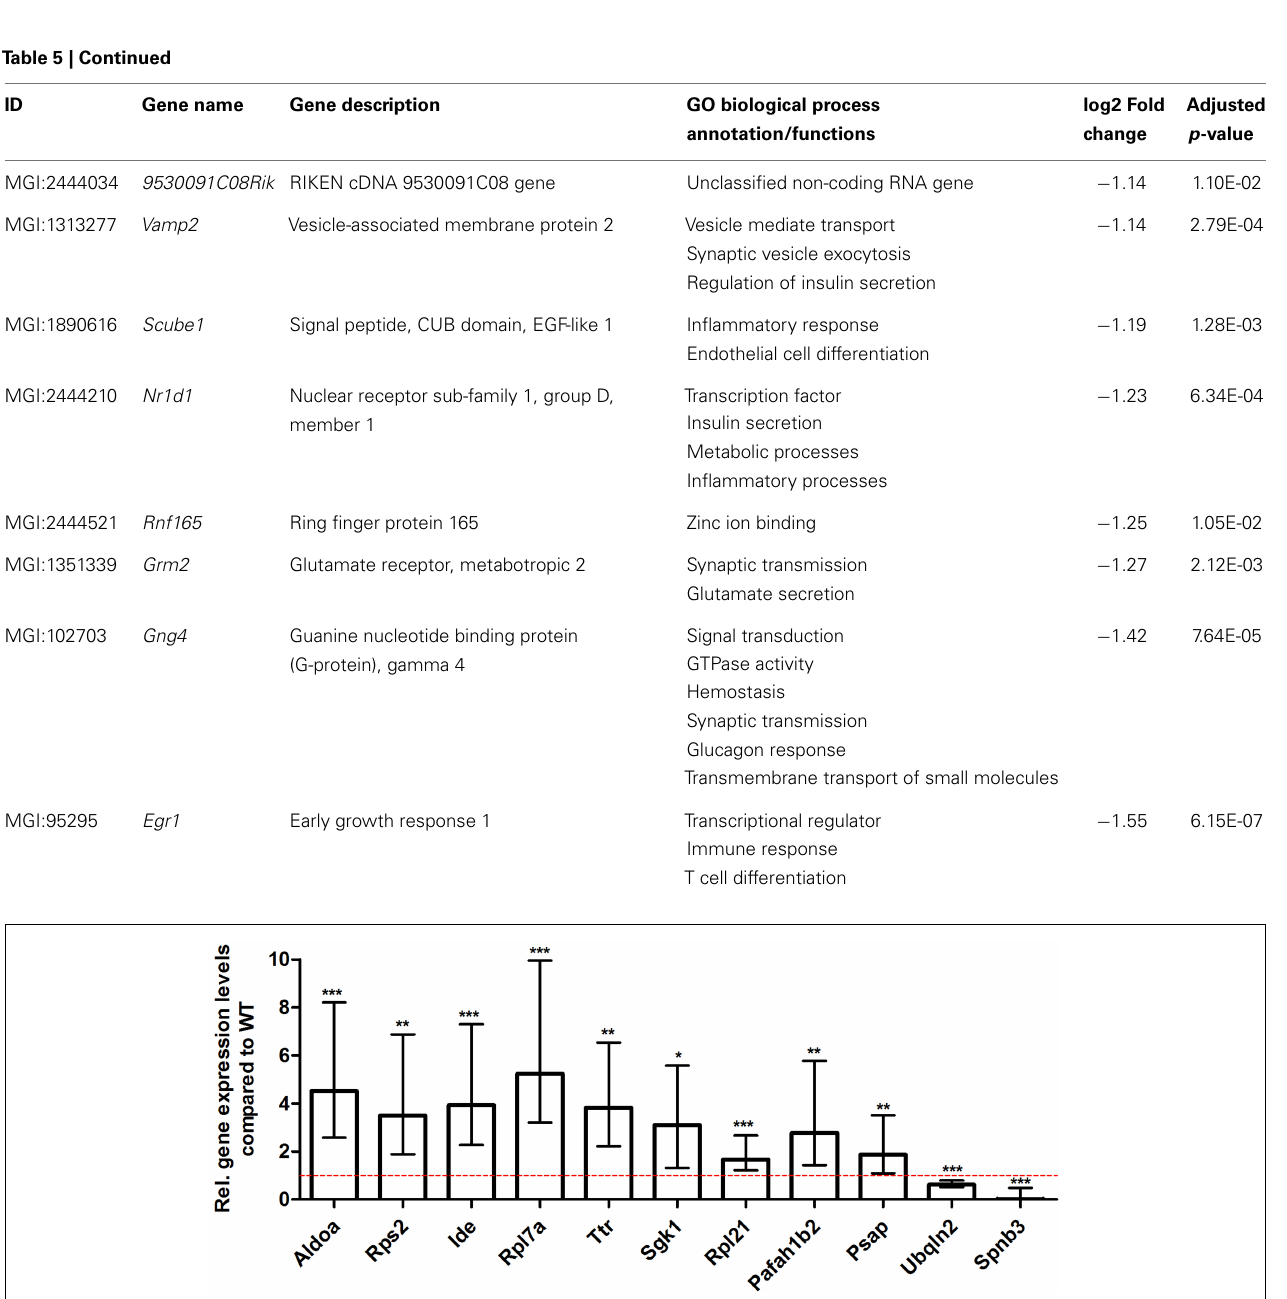
levels of 5XFAD mice were compared to age-matchedWT animals (dashed red line representsWT standard). Normalization was performed against